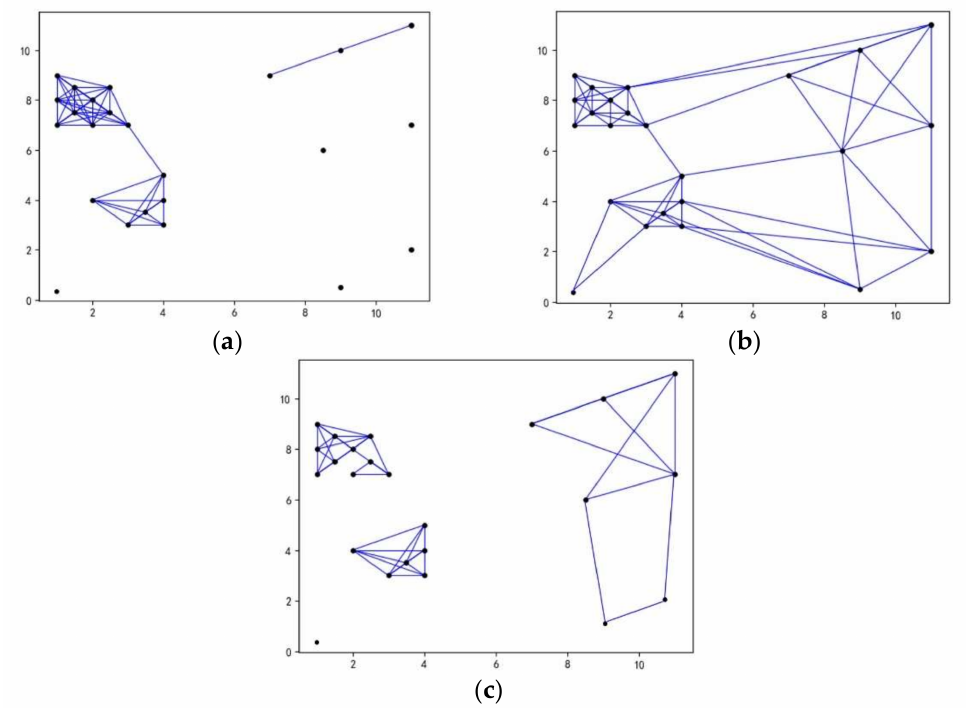
Figure 3. Illustration of the neighbor graph of data points. ( a ) Distance-based neighbor graph (threshold = 2.5). ( b ) k-nearest neighbor graph (k = 5). ( c ) Shared nearest neighbor graph (k =